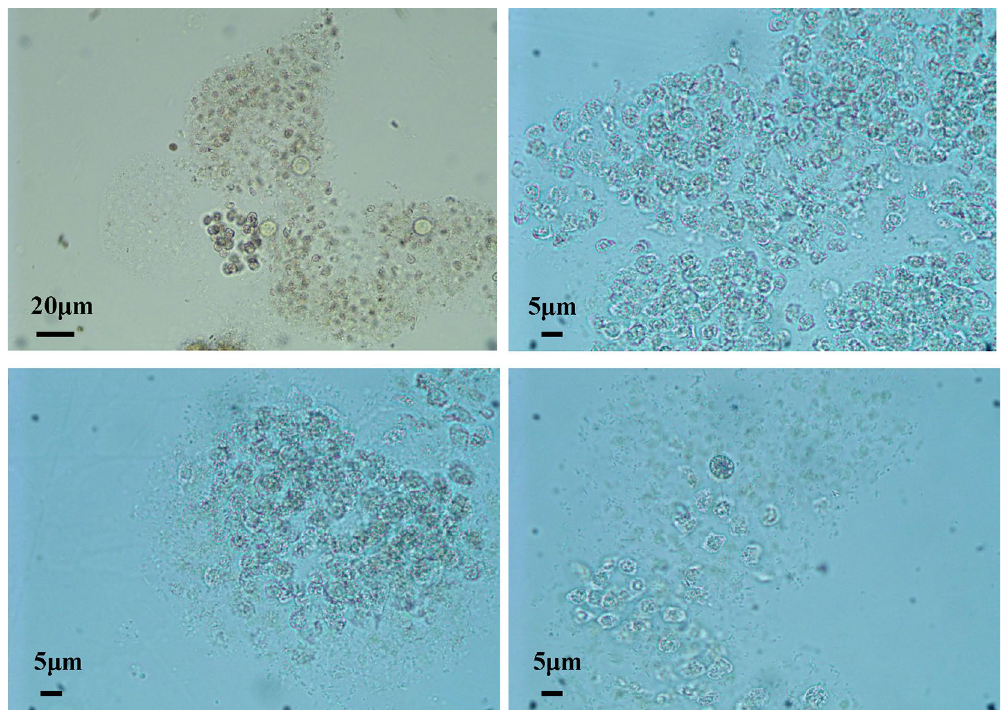
Figure 4. Pictures of the Microcystis colonies during the decomposition in treatment High on day